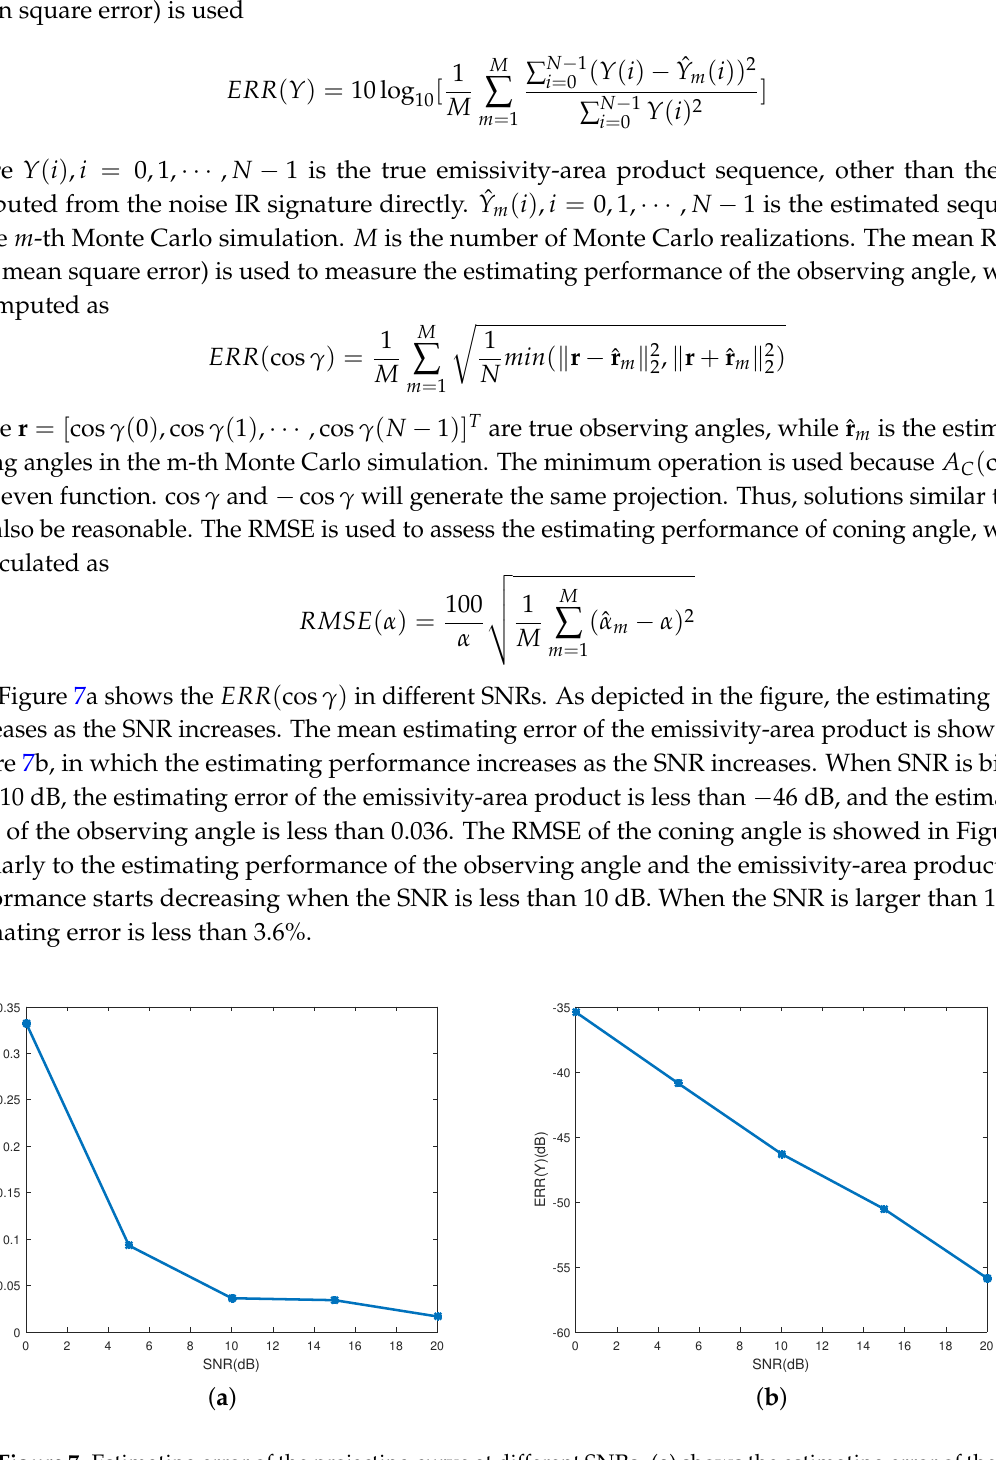
Figure 7. Estimating error of the projecting curve at different SNRs. ( a ) shows the estimating error of the observing angles; and ( b ) depicts the estimating error of the corresponding emissivity-area